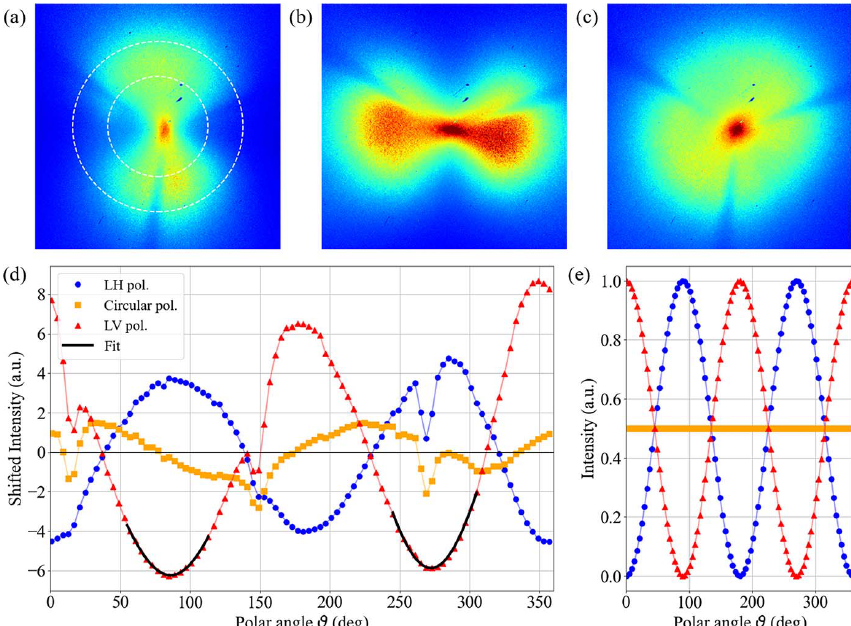
Figure 3 Intensity pattern recorded at 75 eV photon energy with nominally ( a ) LH, ( b ) LV and ( c ) circular polarization. The three images share the same colour bar and have been normalized to the incident beam intensity and to the exposure time. ( d ) Polar profiles obtained for images ( a )–( c ) within the region of interest depicted in panel ( a ). The glitch discontinuities at 30, 150 and 270 (cid:2) are due to the shadow of the mounting frame for the inner conical mirror. ( e ) Calculated polar profiles for ideal polarization states obtained from equation (2), to be compared with panel ( d